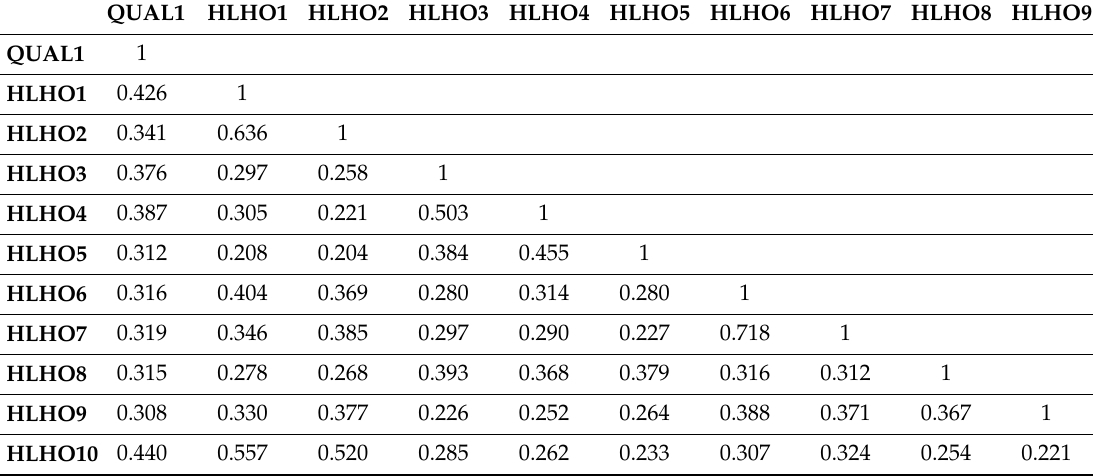
Table 4. Spearman correlation analysis. For each rho value, p <